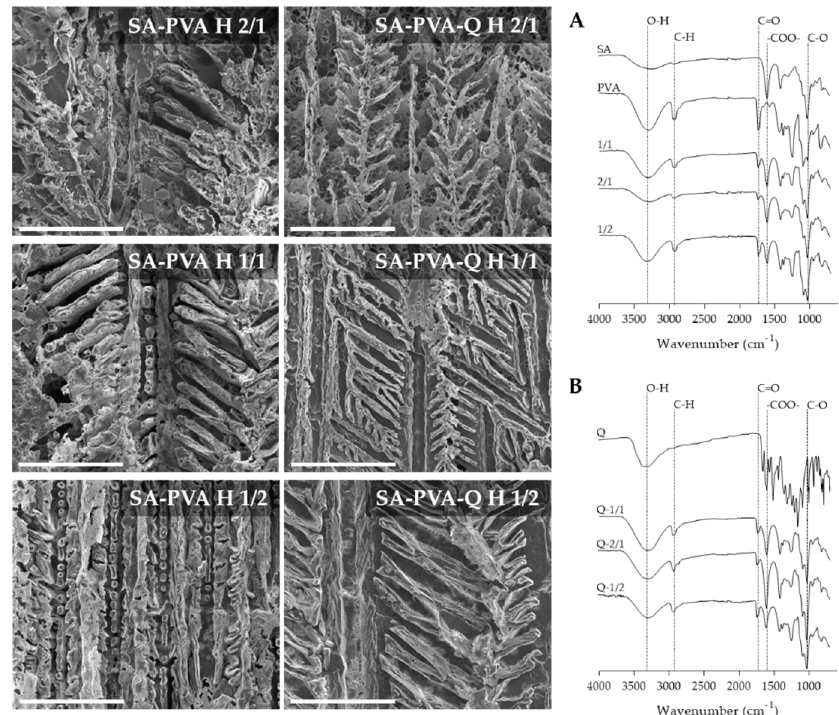
Figure 1. Analysis of the hydrogels morphology (left) and chemical interactions (right). SEM micrographs of quercetin free and quercetin-loaded sodium alginate-poly(vinyl) alcohol (SA-PVA) hydrogels. Scale bar 200 µm. FTIR spectra of empty ( A ) and quercetin-loaded ( B ) hydrogels.